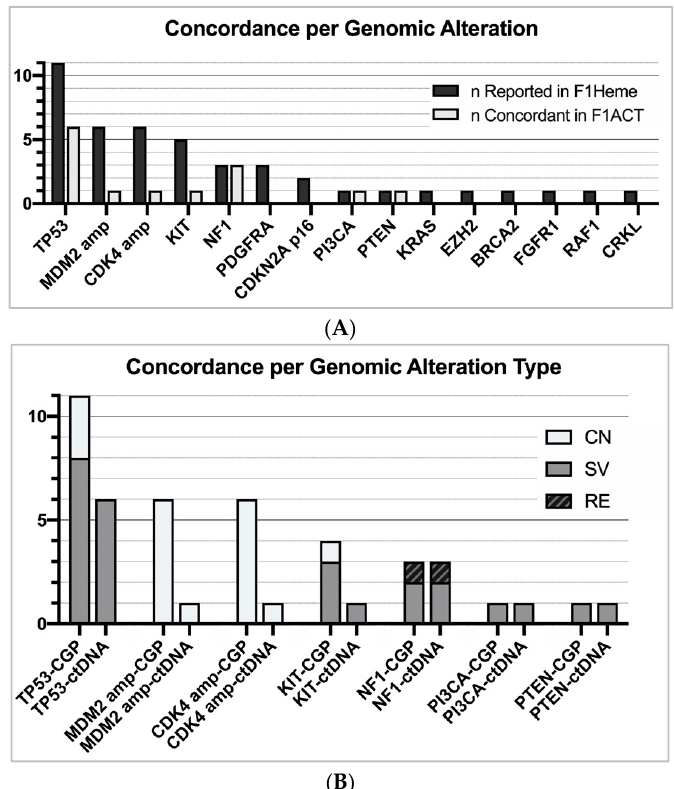
Figure 4. ( A ) Overall concordance between F1Heme and F1ACT per genomic alteration (see Figure S1 for genomic alterations reported in F1ACT not previously stated in F1Heme). ( B ) Concordance between liquid / solid CGP per genomic alteration type. F1ACT performs fairly well in the detection of short variant alterations (SV = 11 / 15). However, F1Heme is inadequate in the detection copy number alterations and losses (CN = 2/16).